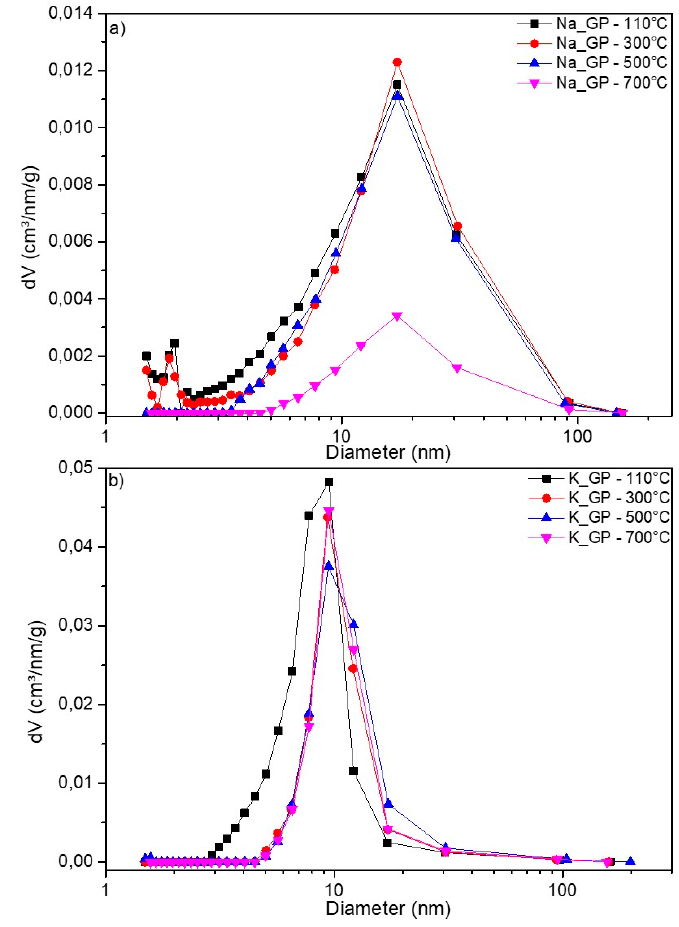
Figure 3. Pore distribution for samples: ( a ) Na-GP; ( b ) K-GP.